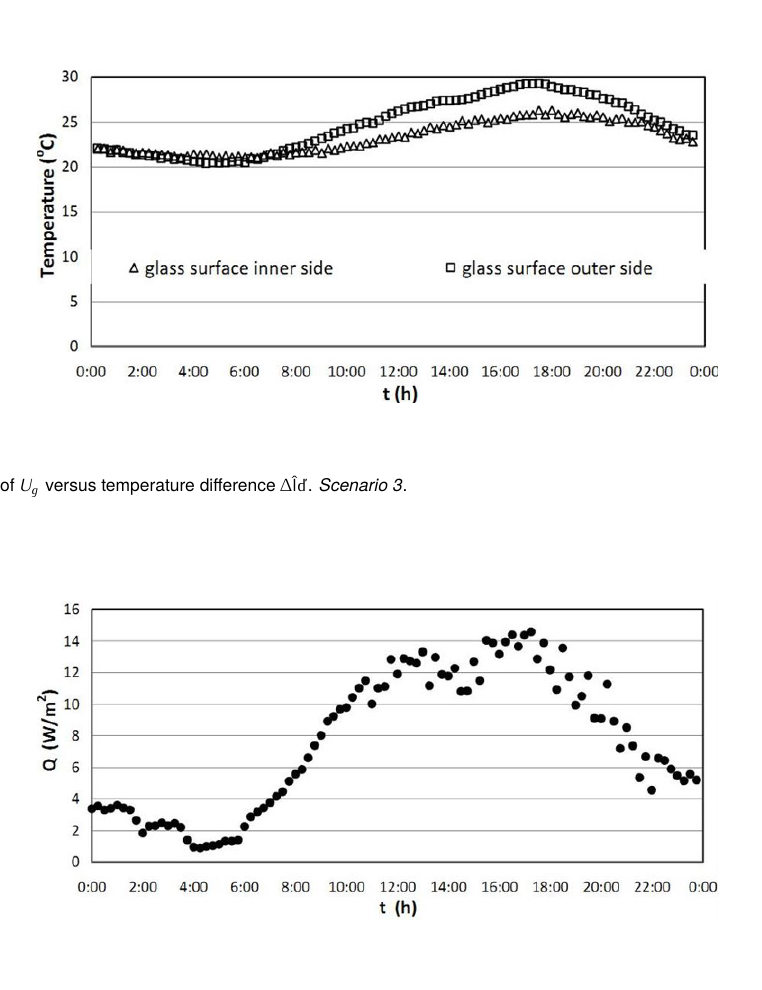
Figure 18. Measured heat flow through the triple glazing. Scenario 3 .